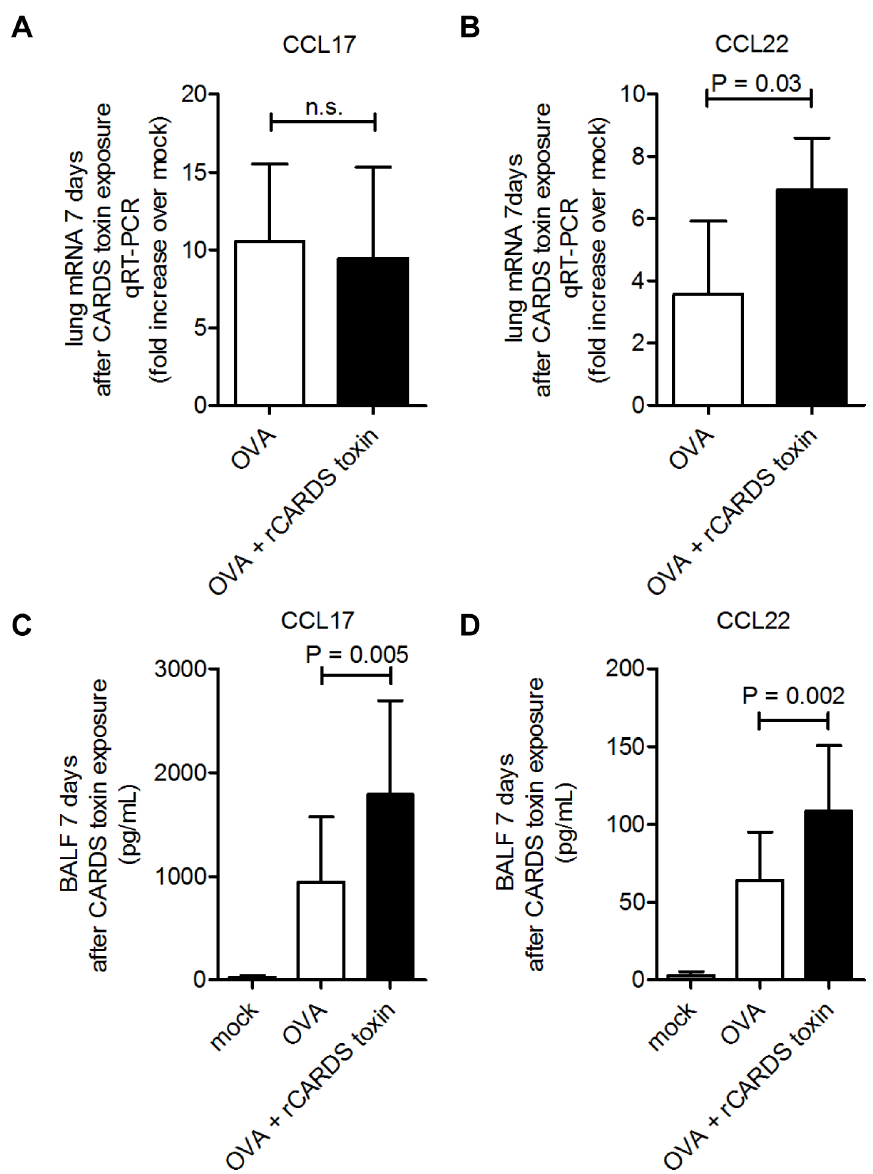
C) CCL17. (p=0.005) and D) CCL22 (p=0.002).